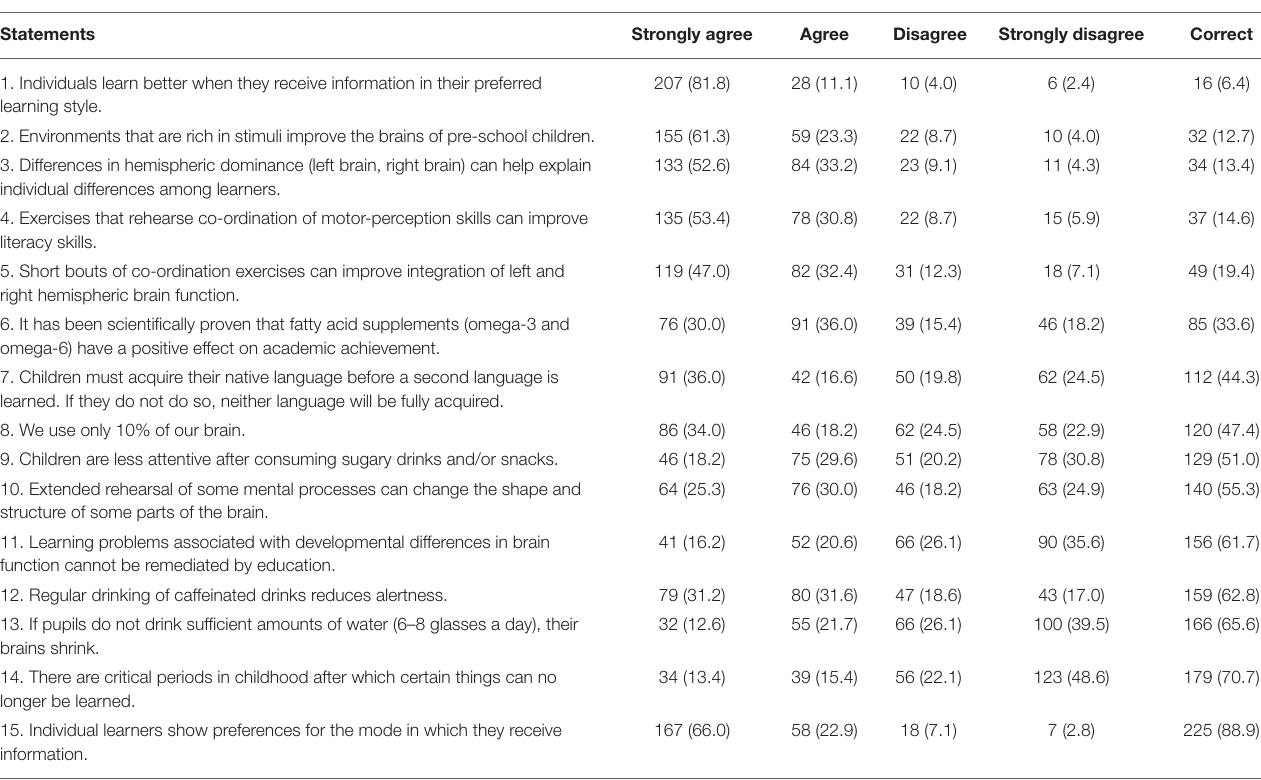
TABLE 1 | Percentage of correct neuromyths.